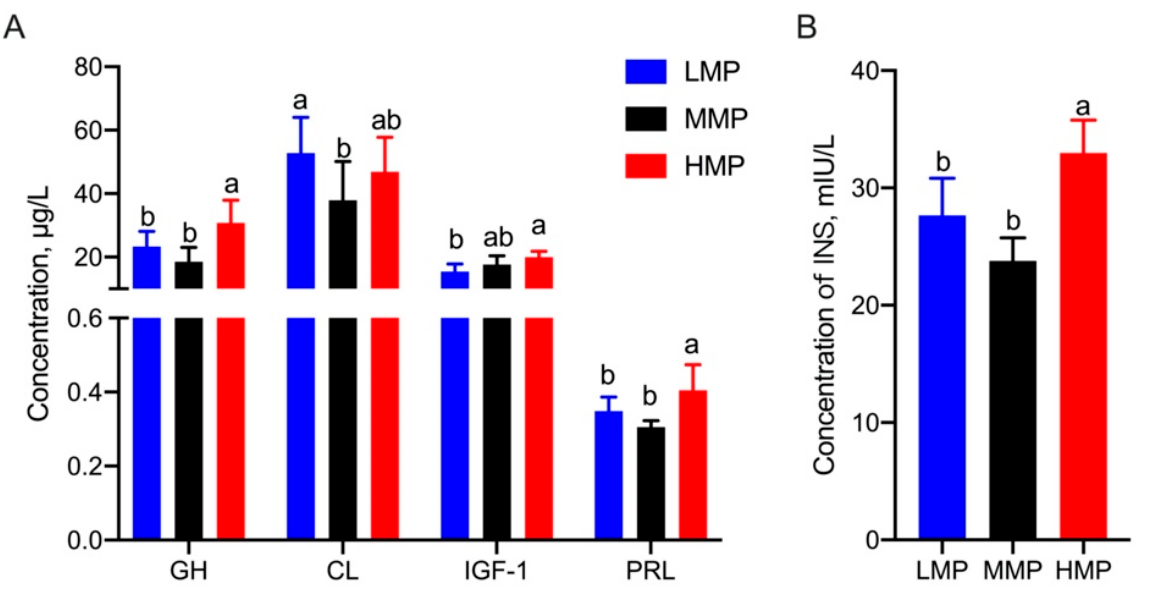
Figure 1. Differential hormones in plasma in dairy cows with different milk protein concentrations. ( A ) Concentrations of GH, CL, IGF-1 and PRL in plasma. ( B ) Concentration of INS in plasma. This experiment was repeated 3 times, and data are reported as mean ± SEM; different superscript letters in the same row indicate significant differences between groups ( p < 0.05). LMP: low milk protein concentration group; MMP: medium milk protein concentration group; HMP: high milk protein concentration group.